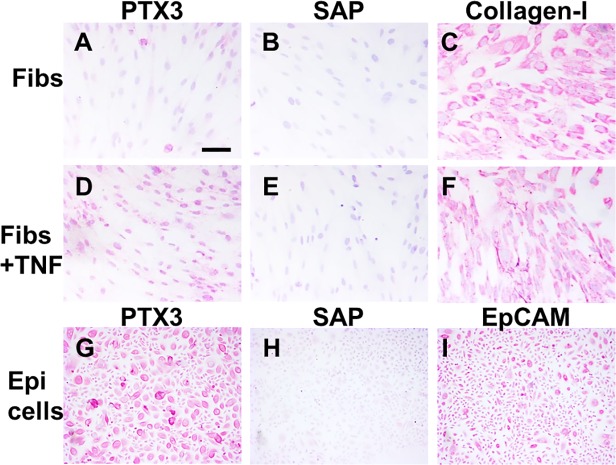
Human lung fibroblasts and epithelial cells express PTX3.Human A-C) lung fibroblasts, D-F) lung fibroblasts incubated with 50 ng/ml TNF-α, or G-I) lung epithelial cells were cultured for 2 days in 8-well glass slides. Cells were then air-dried, fixed, and labeled with A, D, and G) anti-PTX3 antibodies, B, E, and H) anti-SAP antibodies, C and F) anti-collagen I antibodies, or I) anti-EpCAM antibodies. Positive staining was identified by red staining, and nuclei are counterstained blue. Bar is 100 μm.